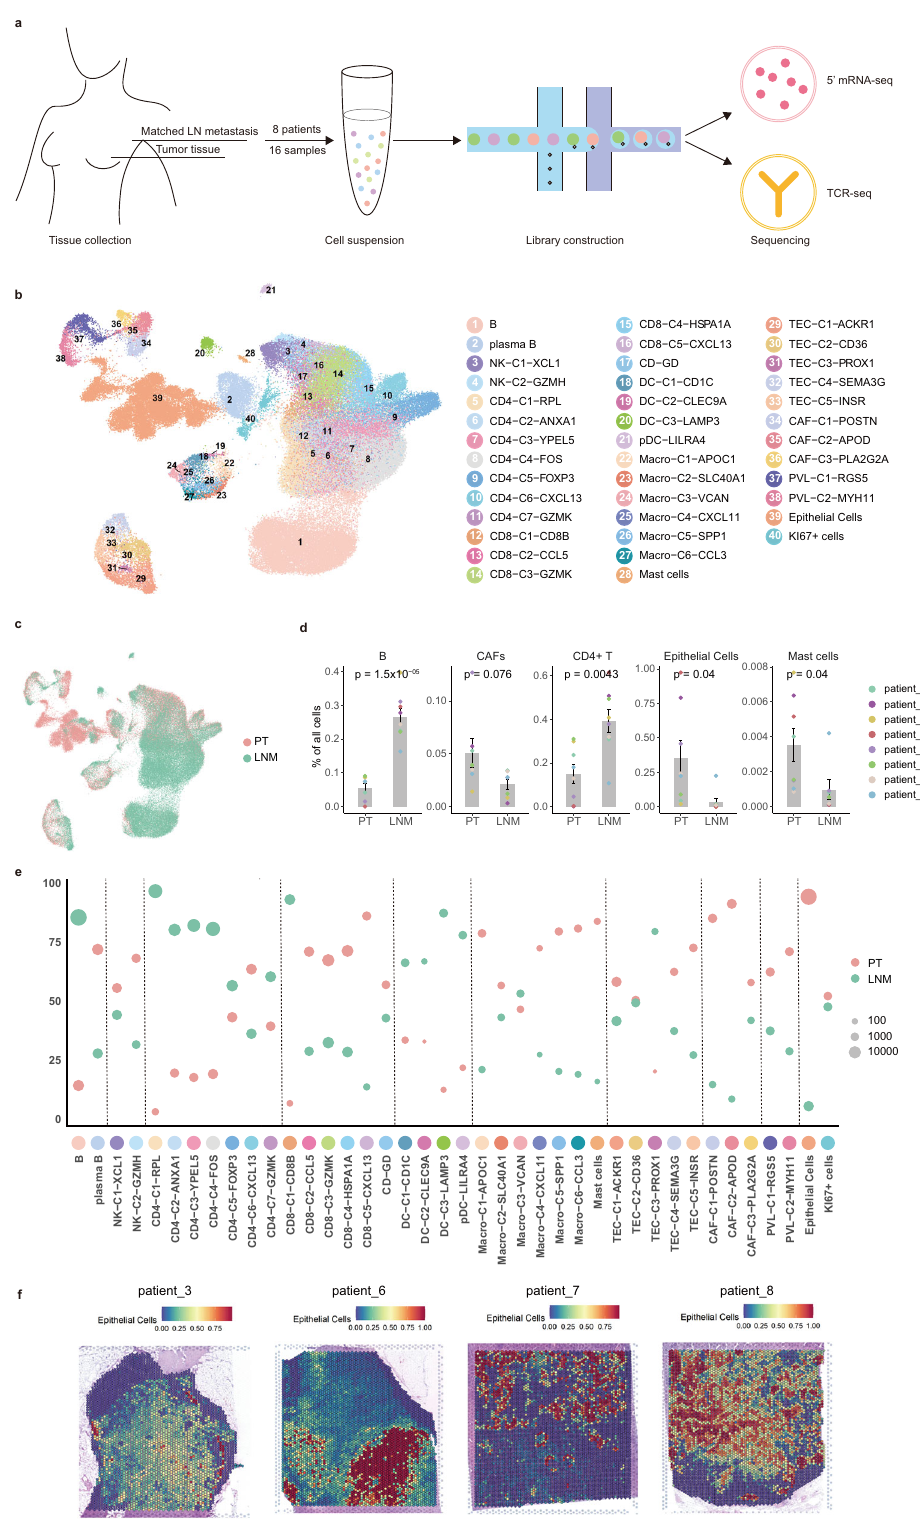
Fig. 1 | Microenvironmental landscape of PT and LNMT in breast cancer. a Diagram of the single-cell sequencing strategy for lymph node metastasis patients. b , c UMAP embedding plot showing identi fi ed clusters of all 118845 cells frompairedPT(primarytumor)andLNMT(lymphnodemetastasizedtumors)of8 LNMTpatients.Cellswerecoloredaccordingtotheirclusters( b )ortissues( c ).The number of cells per cluster, per patient, and per tissue is summarized in Supple- mentarydata2. d Barplotsshowingthedifferencesinthemajorcelltypesbetween